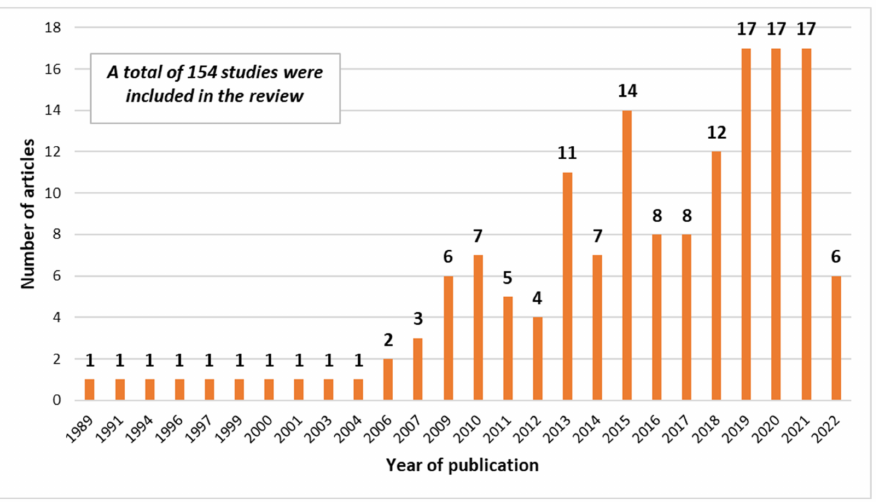
Figure 2. Published papers per year, in the period 1989–2022, according to the review’s criteria.